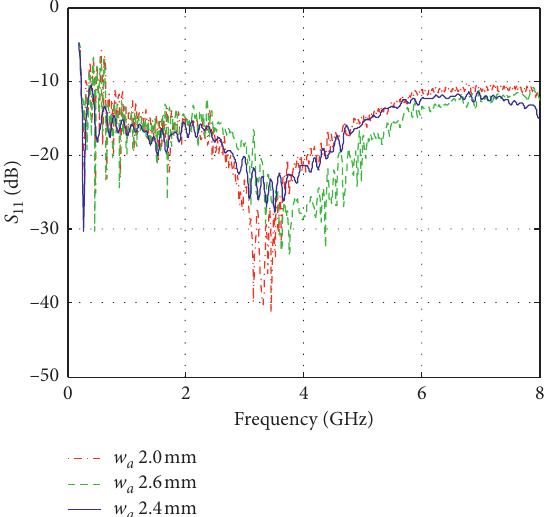
Figure 8: Simulated reflection coefficient of antennas with different w